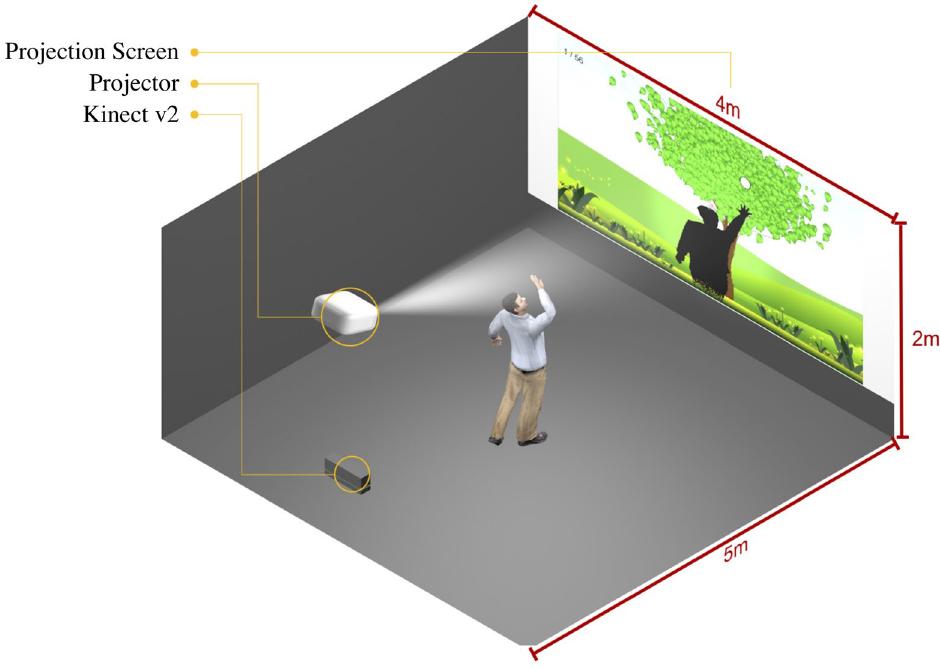
Figure 3. Virtual reality perception test setting. The participant’s full body movements were tracked by an optical tracking system (Kinect v2) and mapped in real-time to the movements of the virtual body on a large